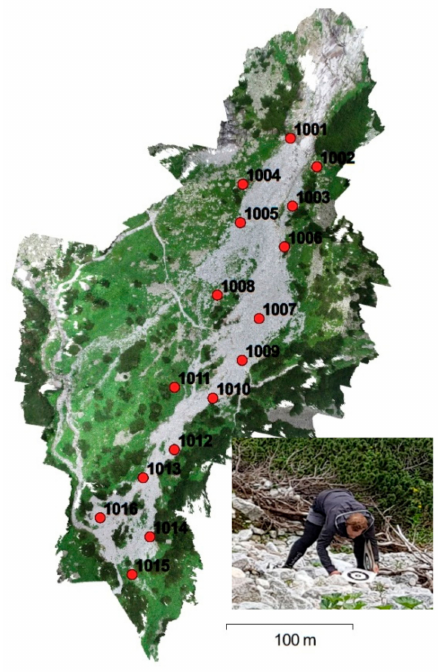
Figure 7. Location of ground control points (red dots) and installation of a ground control